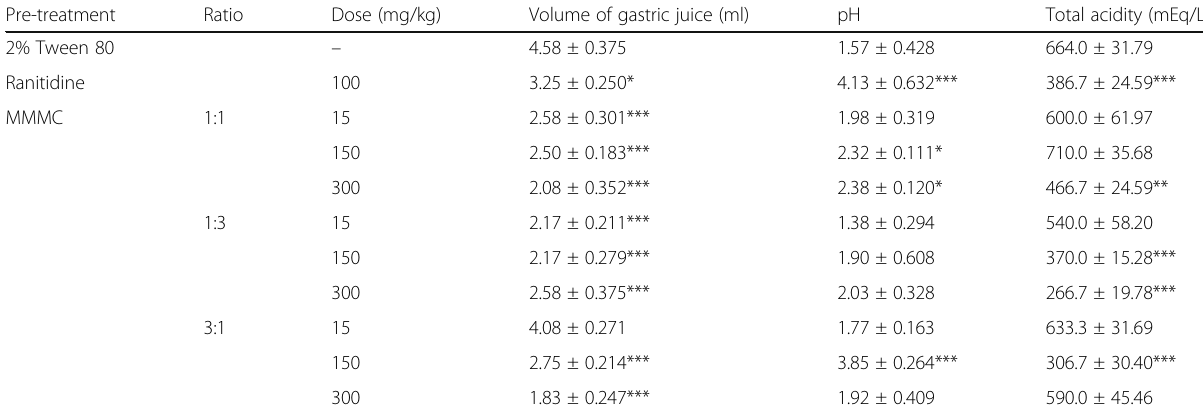
Table 2 Effect of MMMC on several gastric content parameters assessed using the pylorus-ligated rat model Pre-treatment Ranitidine